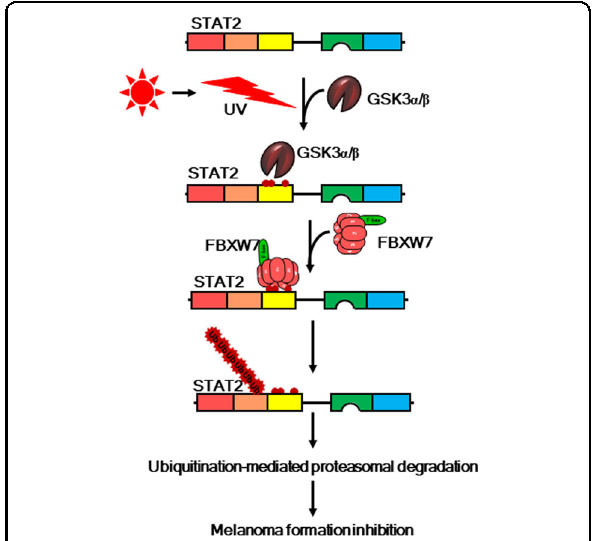
Fig. 4 New paradigm for the regulation of STAT2 protein in melanoma formation. In normal cells, STAT2 protein levels are maintained at low levels. When cells are stimulated by UV, especially UVB, GSK3 α / β phosphorylates STAT2 at the DBD, which recruits the SCF FBXW7 complex to form the SCF FBXW7 – STAT2 complex. FBXW7 catalyzes K48 STAT2 polyubiquitination, resulting in a reduction in STAT2 protein levels via the proteasomal degradation pathway. Thus, cell proliferation at the acute stage is initially suppressed after UVB irradiation. However, in cancer cells with FBXW7 mutation(s), higher STAT2 protein levels are sustained compared to that of normal cells, resulting in the induction of cell